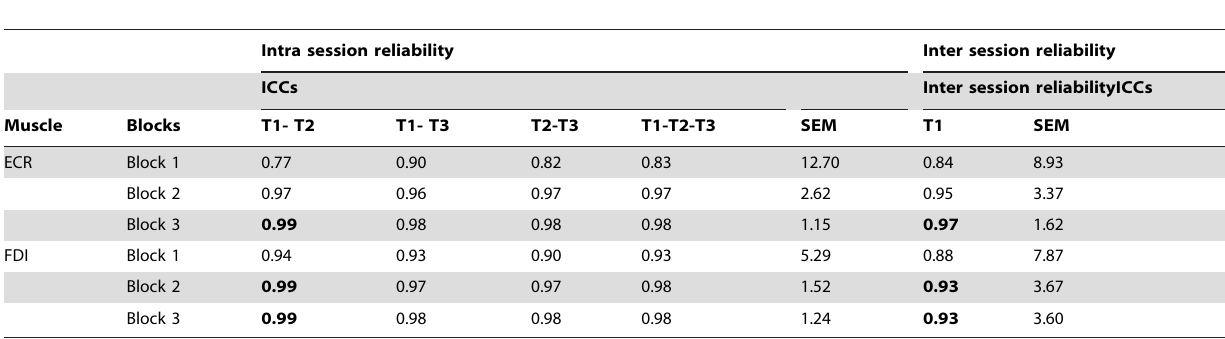
Table 3. Comparison of between MEPs correlation of the recorded MEPs amplitude from ECR and FDI